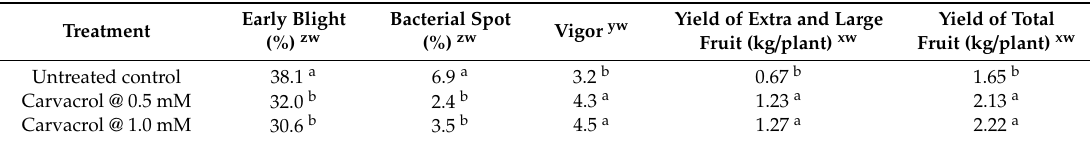
Table 4. Foliar application of carvacrol on disease severity of bacterial spot, plant vigor and yield of tomato in the